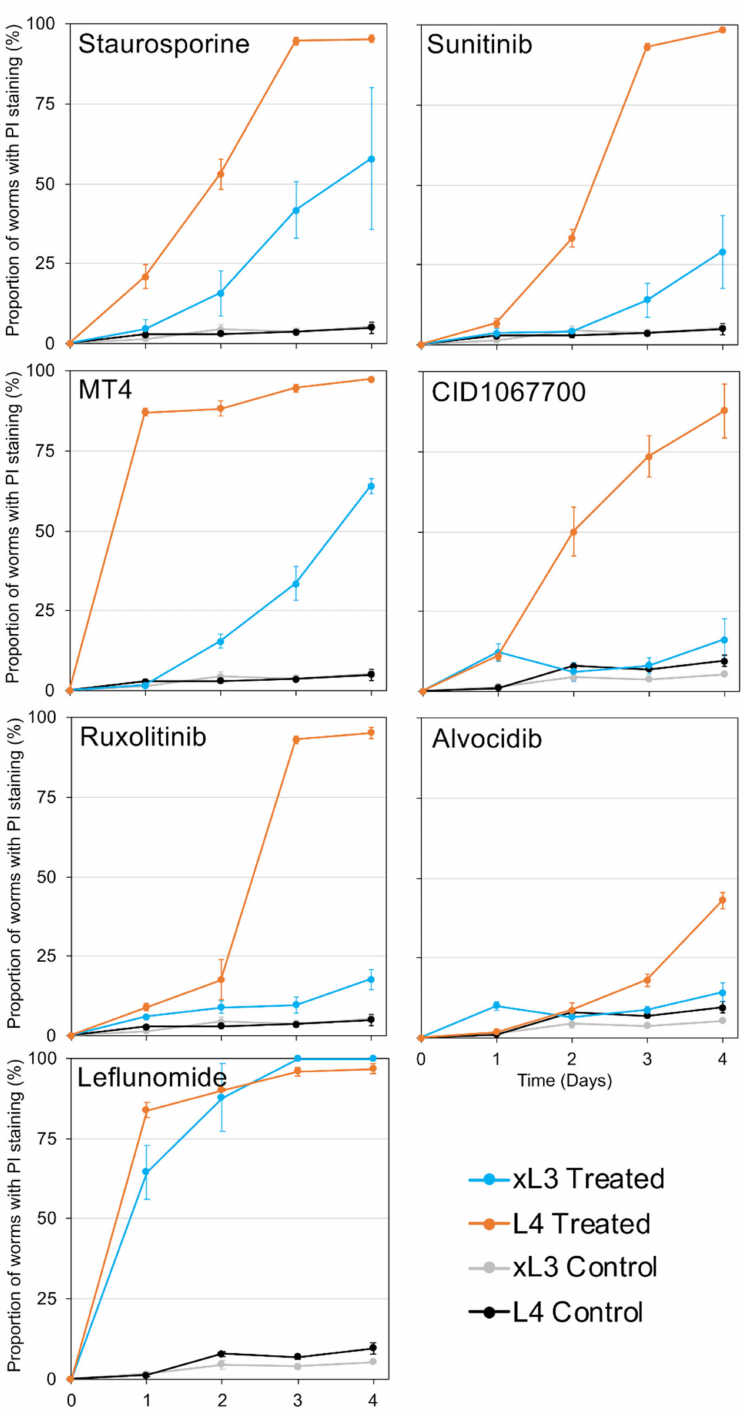
Figure 6. Time-course PI cell death assays for NITs of interest and untreated controls, for xL3 and L4 H. contortus larvae. All NITs were applied with a concentration of 500 µ M except Staurosporine at 25 µ